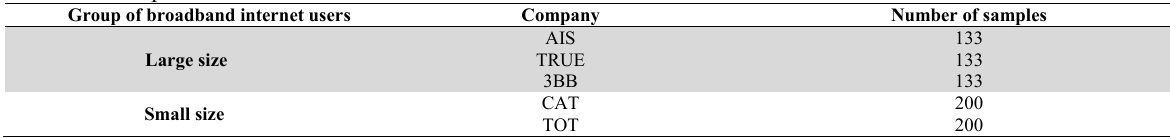
Number of samples Group of broadband internet